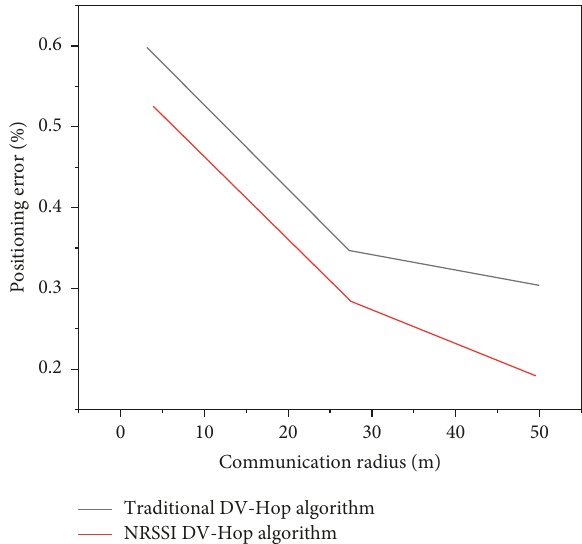
Figure 11: Unknown node positioning error under different communication